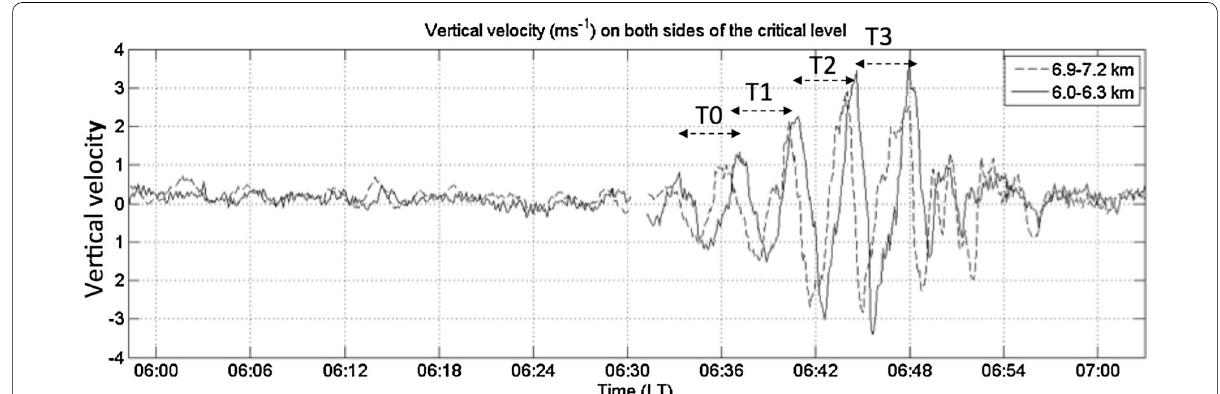
Fig. 6 Time series of W averaged over 300 m on both sides of the critical level. T0 ~ 210 s, T1 ~ 216 s, T2 ~ 230 s and T3 ~ 209 s, for an average of 221 s and a wavelength of 3.71